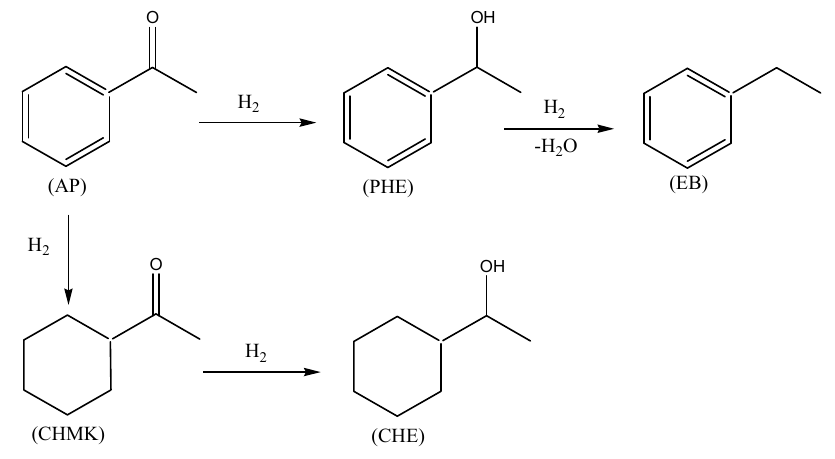
Figure 6. Reaction network of AP hydrogenation on the metal catalysts.